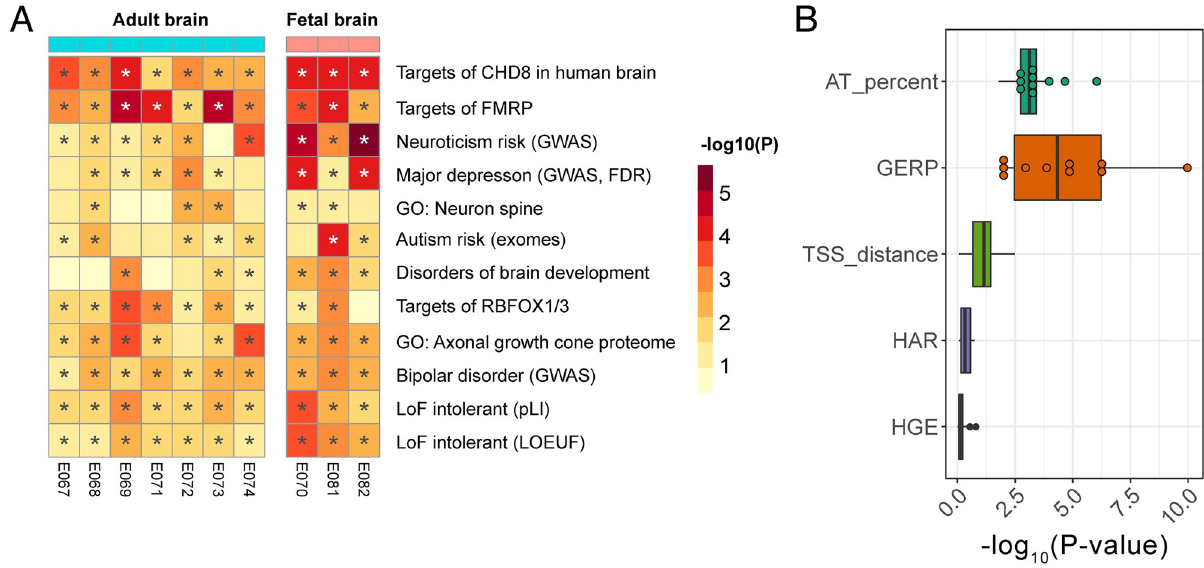
Fig 5. Features of brain-expressed enhancers associated with schizophrenia risk. A) Risk-associated enhancers are in physical contact with gene sets previously implicated in risk for neuropsychiatric disorders. Shown here are gene sets with a median p-value across the 10 brain enhancer samples < 0.05. GWAS = genes at GWAS risk loci. Full description of gene lists available in Methods. B) Evolutionary conservation and AT-richness of enhancers were associated with schizophrenia risk. HGE/HAR status and distance to the nearest gene TSS were not associated with risk.